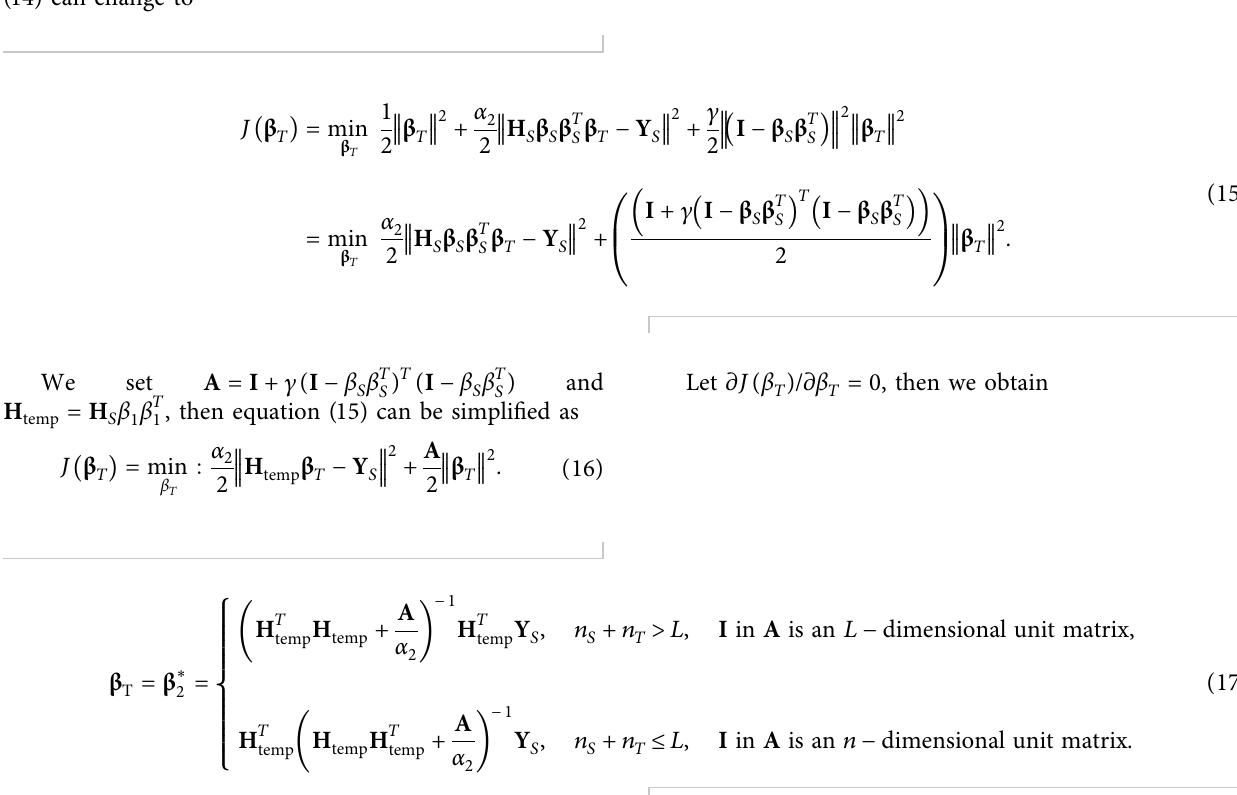
Figure 2): Tese datasets were frst published in the year referred in [43]. It contains two domains, namely, Ofce31 and Caltech256. Ofce31 consists of 4,652 images in